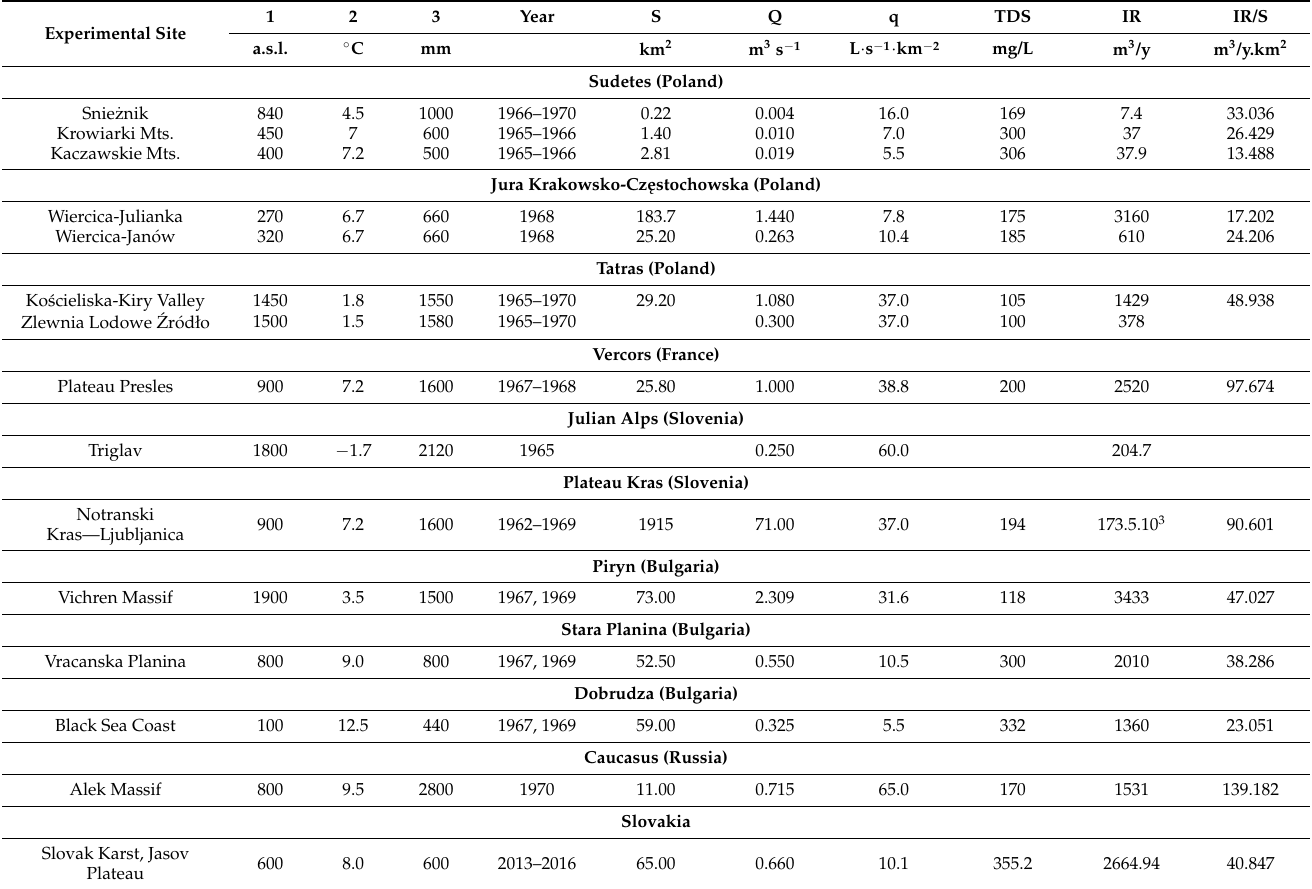
Table 2. Ionic runoff in karst areas of Europe